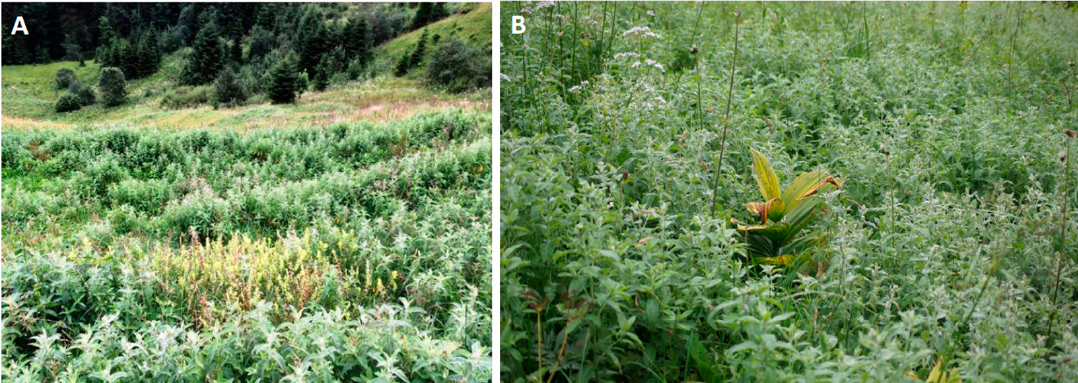
Figure 1. Horsemint can outcompete other species. ( A ) Overgrown mountain pasture at Alp Rossweid close to Lake Sihl, near Einsiedeln, Canton Schwyz, Switzerland. ( B ) Detail showing how M. longifolia has almost eliminated other species, with just one specimen of White Hellebore ( Veratrum album ) being able to remain. Images courtesy of Franz Steiner (Research Institute of Organic Agriculture, FiBL, Frick, Switzerland).